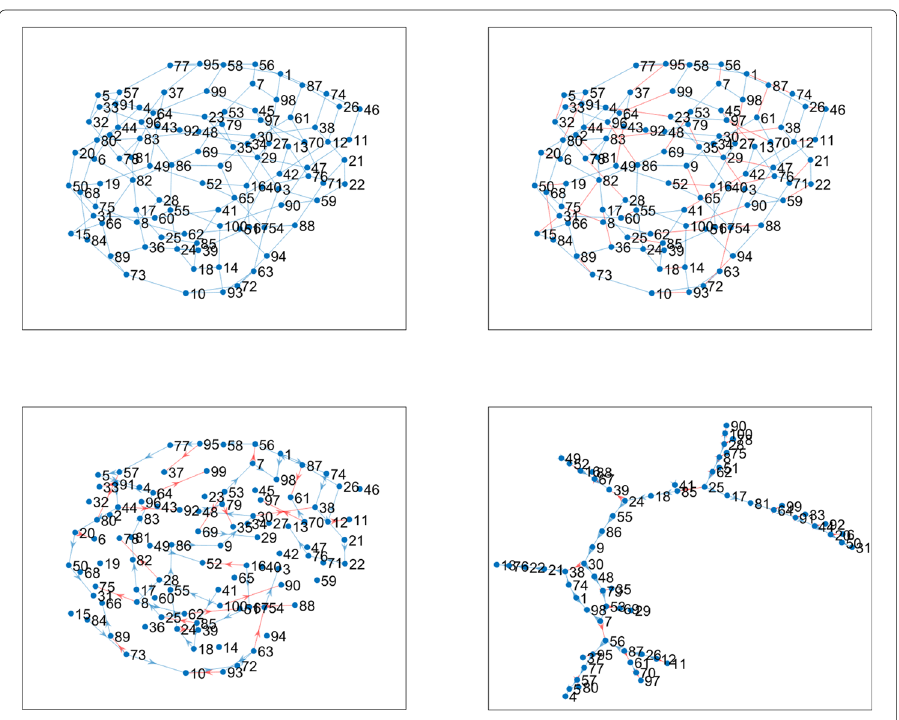
Fig. 1 Phase I of Algorithm